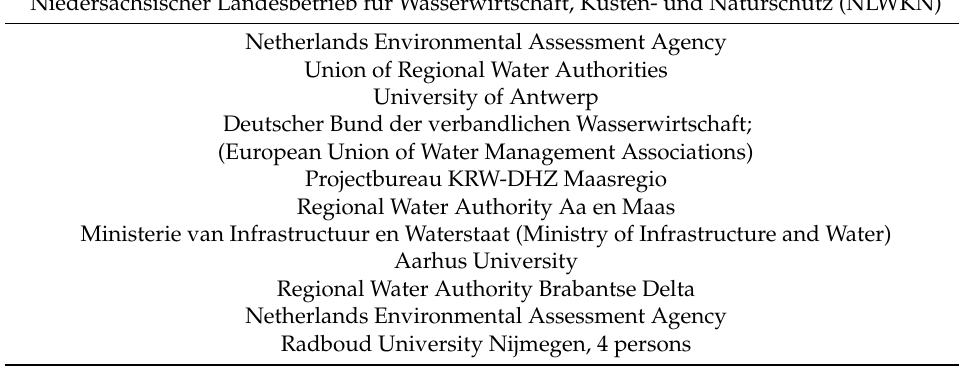
Table A2. Organizations in International Workshop–12 April 2018 (Made Anonymous).